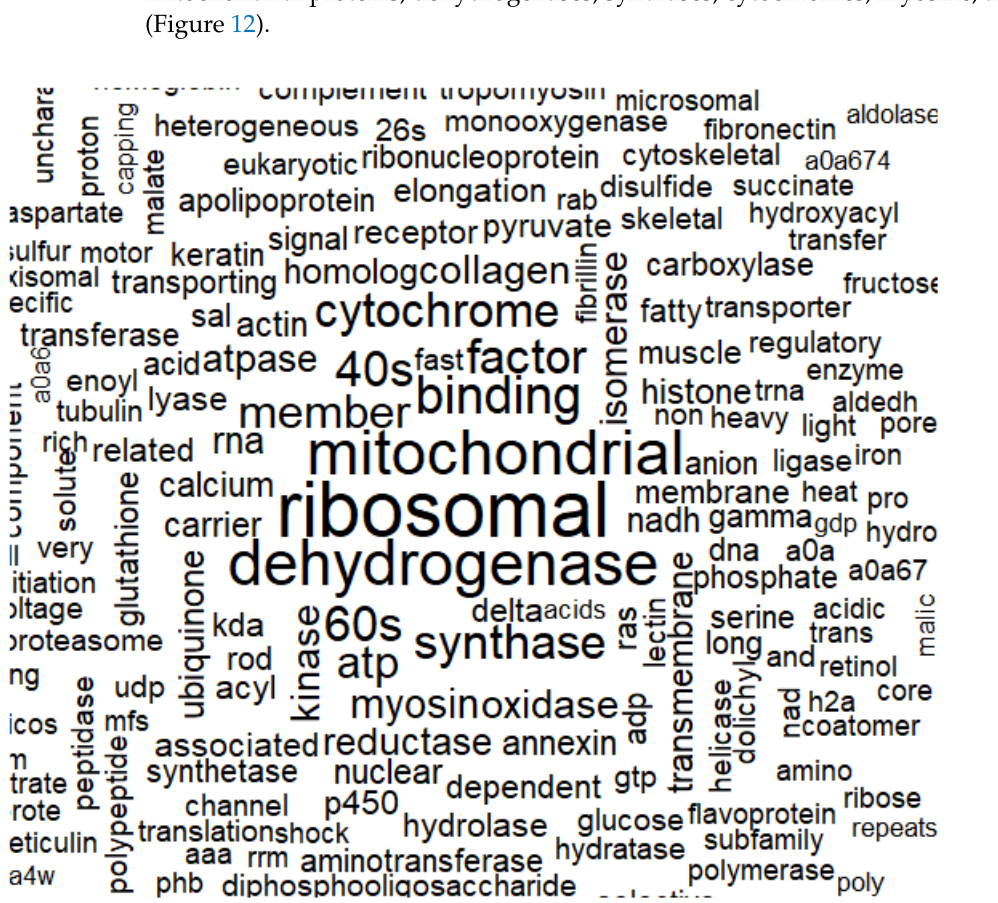
Figure 11. Venn diagram for the proteome of underyearlings of Atlantic salmon ( Salmo salar L.) for the control and experimental groups.